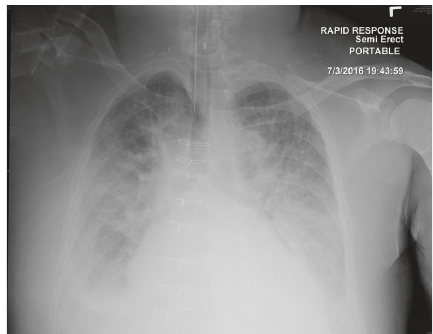
Figure 2: Portable chest radiograph on day 2 following intubation for respiratory distress showing worsening bilateral opacities and hilar congestion.